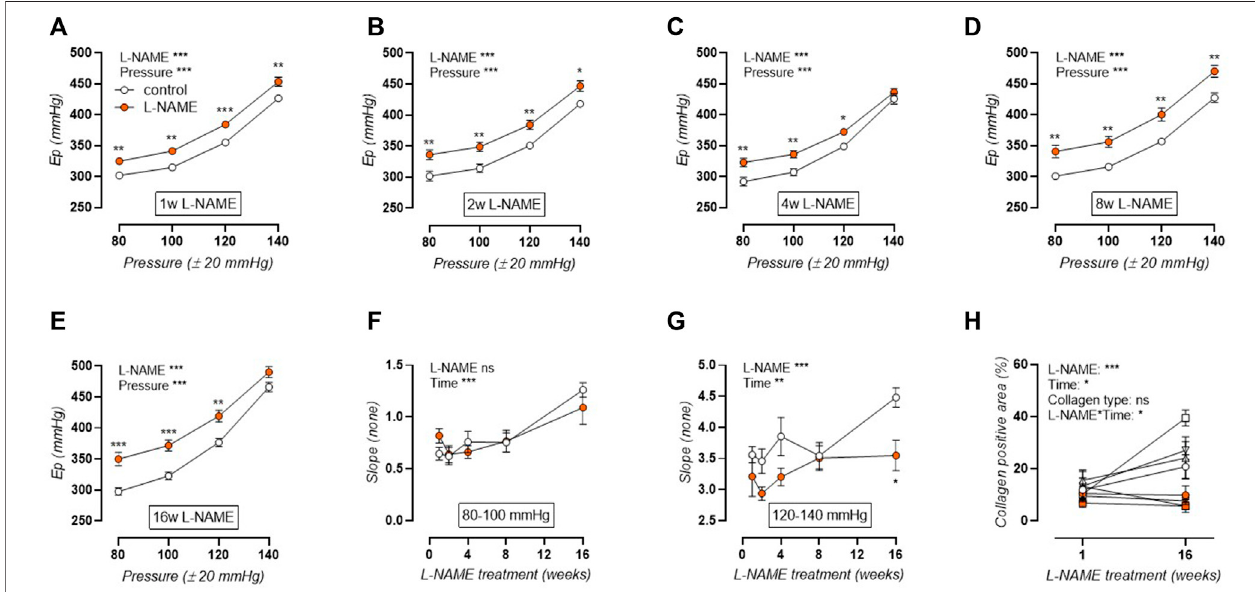
FIGURE 4 | Aortic stiffness-pressure relation is attenuated by L-NAME treatment. Peterson modulus (E p )-pressure curves are shown for increasing treatment durations: 1 week (A) , 2 weeks (B) , 4 weeks (C) , 8 weeks (D) and 16 weeks (E) L-NAME treated (n ≥ 7) and control (n ≥ 9) mice. Theslopeof the lower (mean pressure 80 mmHg to mean pressure 100 mmHg, (F) ) and upper (mean pressure 120 mmHg to mean pressure 140 mmHg, (G) ) range of the E p -curve was calculated and plotted longitudinally. Collagen composition was determined using immunohistochemical staining (n = 5) for collagen I (circles, (H) ), collagen III (squares, (H) ), and collagen IV (upward triangle, (H) ). The average value for collagens I, III, and IV was included in the graph (downward triangle, (H) ), but was not included in the statistical analysis.Statisticalanalysisusingtwo-wayANOVA (A – G) orthree-wayANOVA (H) .Overallsigni fi cance(top)andpost-hocsigni fi cance(ingraph)arelisted.Nopost-hoc signi fi cance is listed in H. * p < 0.05, ** p < 0.01, *** p <